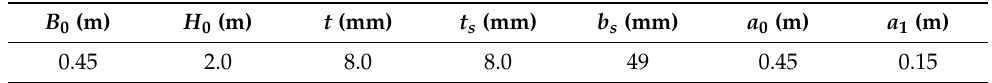
Table 2. Cyclic hardening parameters of Q345qC steel [29,30].